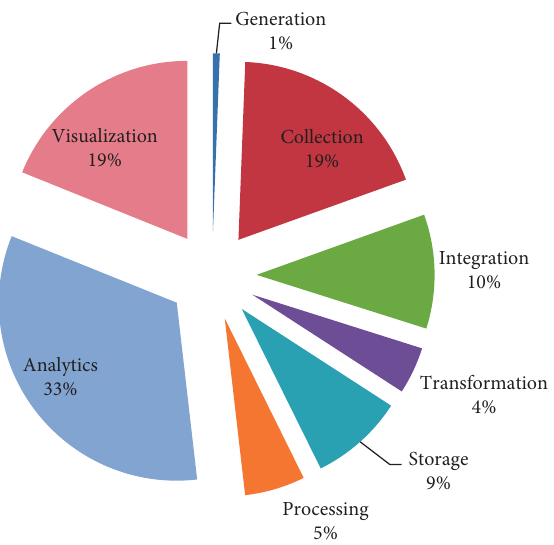
Figure 3: Distribution of reviewed articles by technology